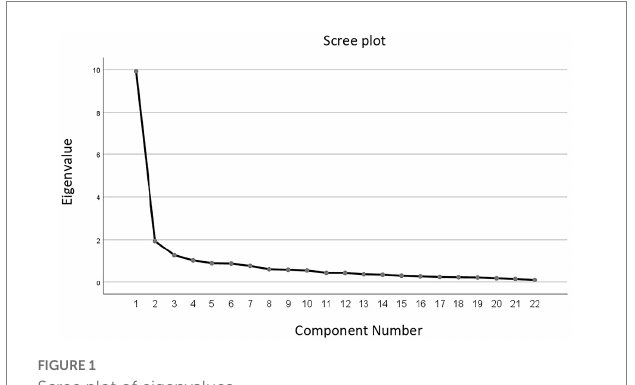
FIGURE 1 Scree plot of eigenvalues.